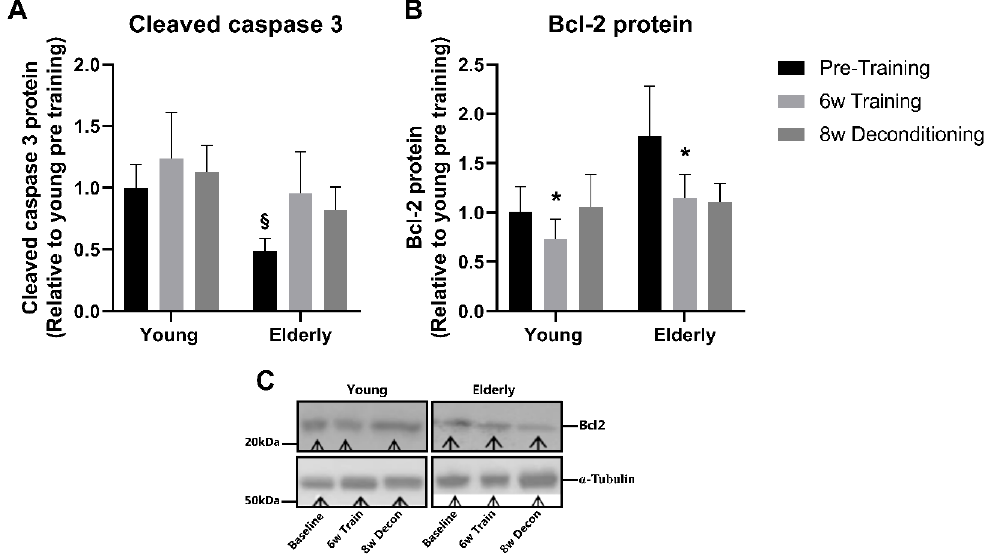
Figure 4. Apoptosis markers. Protein expression of cleaved caspase-3 ( A ) and B-cell lymphoma 2 (Bcl2) ( B ) in skeletal muscle pre and post 6 weeks of aerobic exercise training and after subsequent 8 weeks deconditioning period in young and elderly individuals. n = 10 in young group and n = 11 in the elderly group; however, due to lack of samples, only n = 6 in both groups in ( B ). ( C ) representative Western blots. Values are arbitrary units (means ± SE) and expressed relative to young group pretraining. § p < 0.05, young vs. elderly group within pretraining. * p < 0.01, main effect of training compared to pretraining independently of age.